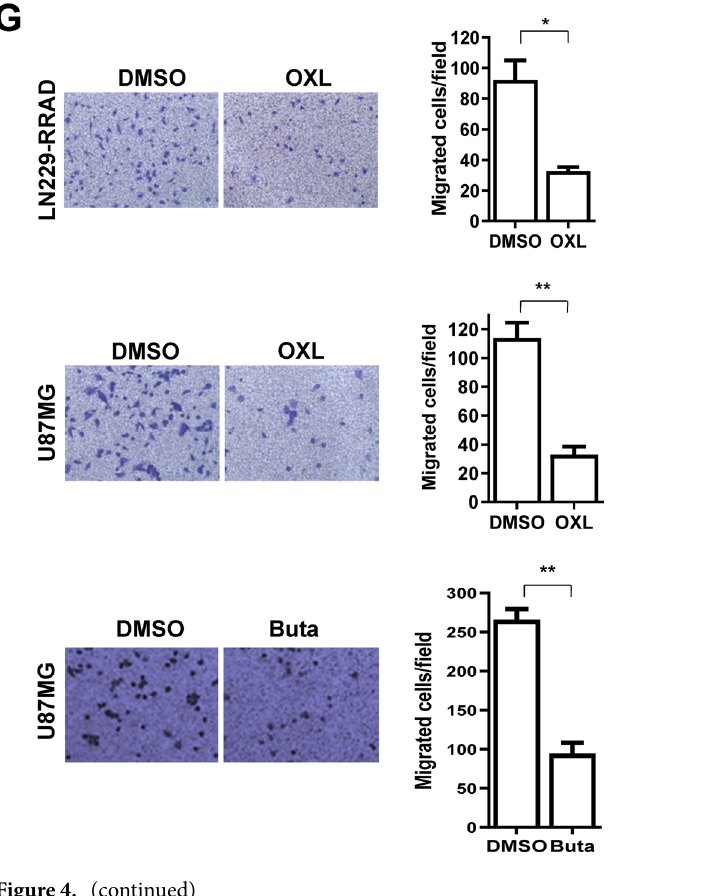
Figure 4. Comparison of the effects of oxelaidin with those of the structurally related antitussive agents. ( A ) Structures of antitussive agents, butamirate citrate, pre-084 and caramiphen. ( B ) U87MG, U87MG-TMZ- resistant (U87 TMZR), U87MG-lapatinib-resistant (U87 LAPAR) and T98G (TMZ resistant) tumorspheres were cultured in the presence of indicated drug for 7 days and the number of tumorspheres counted. ( C ) Dose– response curves showing the survival of LN229-RRAD after treatment with the indicated doses of oxelaidin or butamirate for 7 days, followed by tumorsphere counting. (** P ≤ 0.01 and ***P < 0.001). Error bars represent ± SD. ( D ) Butamirate downregulates STAT3 activity in LN229-RRAD but not in LN229-Vector cells. ( E ) Butamirate downregulates pEGFR, pSTAT3, pAKT and pERK Western blot analysis of protein expression of pEGFR, pSTAT3, pAKT and pERK using actin as a loading control. ( F ) Inhibitory effects of Butamirate on EGF- induced STAT3 activity and the RRAD-pSTAT3 interaction. PLA of RRAD and activated STAT3 in U87MG performed using RRAD antibodies and pSTAT3 Y705 antibodies. U87MG cells were pretreated with butamirate for 2 h, followed by stimulation with EGF (50 ng/mL) for 15 min. Red dots represent interaction signals. Nuclei were stained with DAPI. Representative images from analyses of two independent slides. Fluorescent signals were detected and images captured at × 400 magnification. Error bars represent ± SD. ( G ) Transwell migration assay. LN229 and U87MG cells were exposed to 5 μM oxelaidin or butamirate for 2 h before cell migration. Results are presented as means ± SD (n = 3). (* P ≤ 0.05; ** P ≤ 0.01; *** P